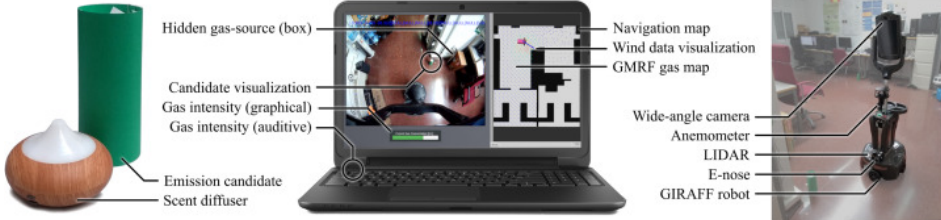
Figure 10. ( Left ) Ultrasonic scent-diffuser and one of the gas source candidates. ( Middle ) User interface for teleoperating the robot running on a laptop. ( Right ) Giraff telepresence-robot equipped with an e-nose and an anemometer for remote sensing, and a LIDAR for